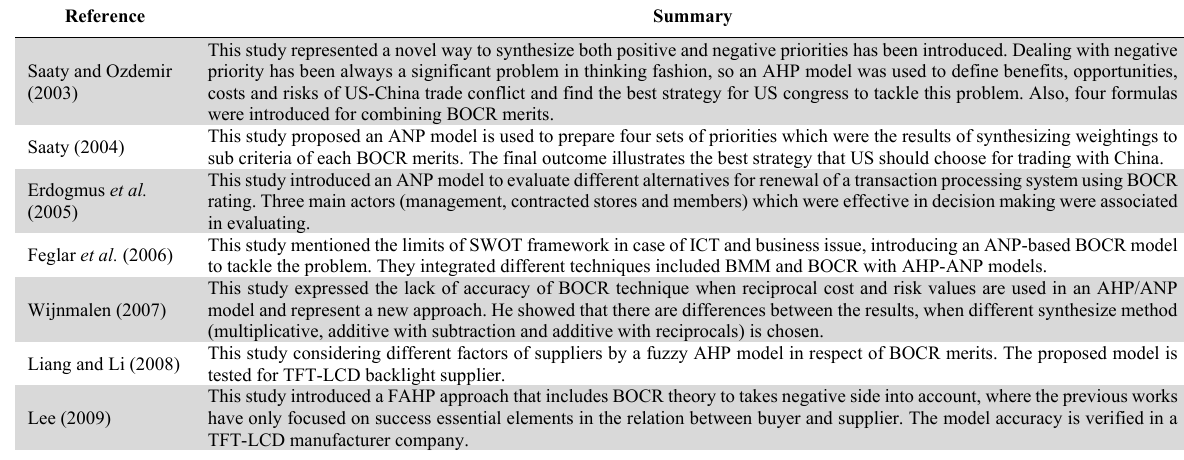
Summary of some relevant prior studies about BOCR technique and MCDM